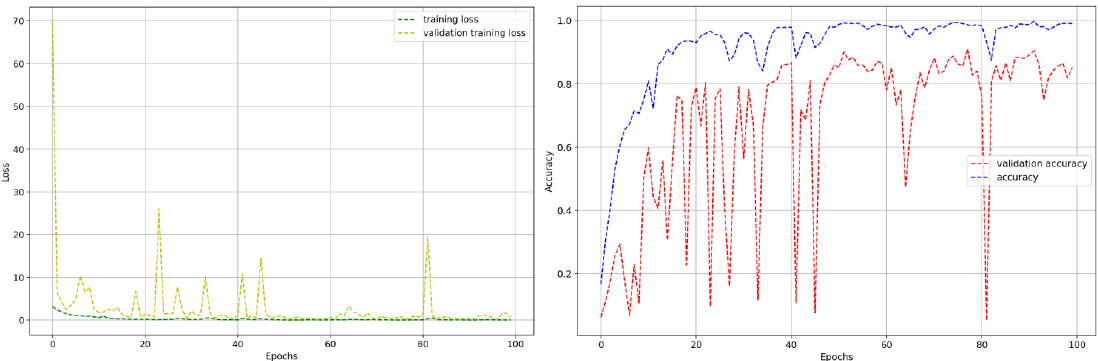
Figure 9. Training/testing loss and accuracy of the proposed deep convolutional neural